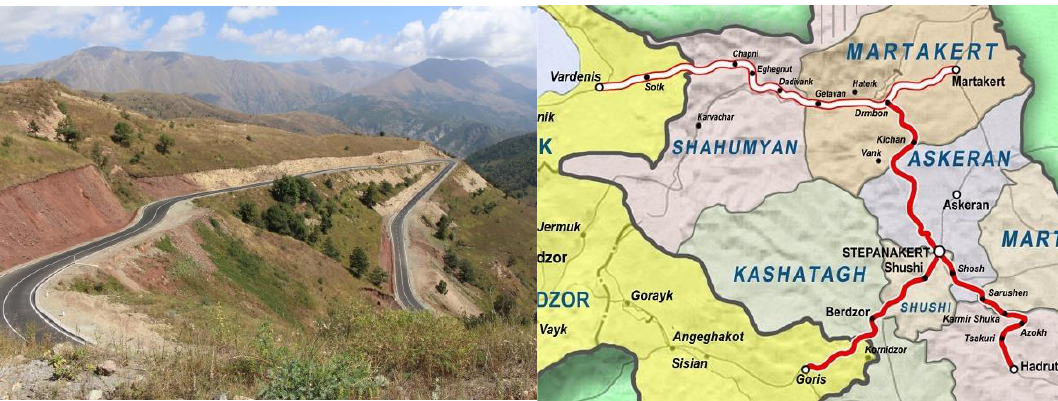
Figure 2. The Vardenis-Agdara highway, which was used for illegal activities/transportation during the